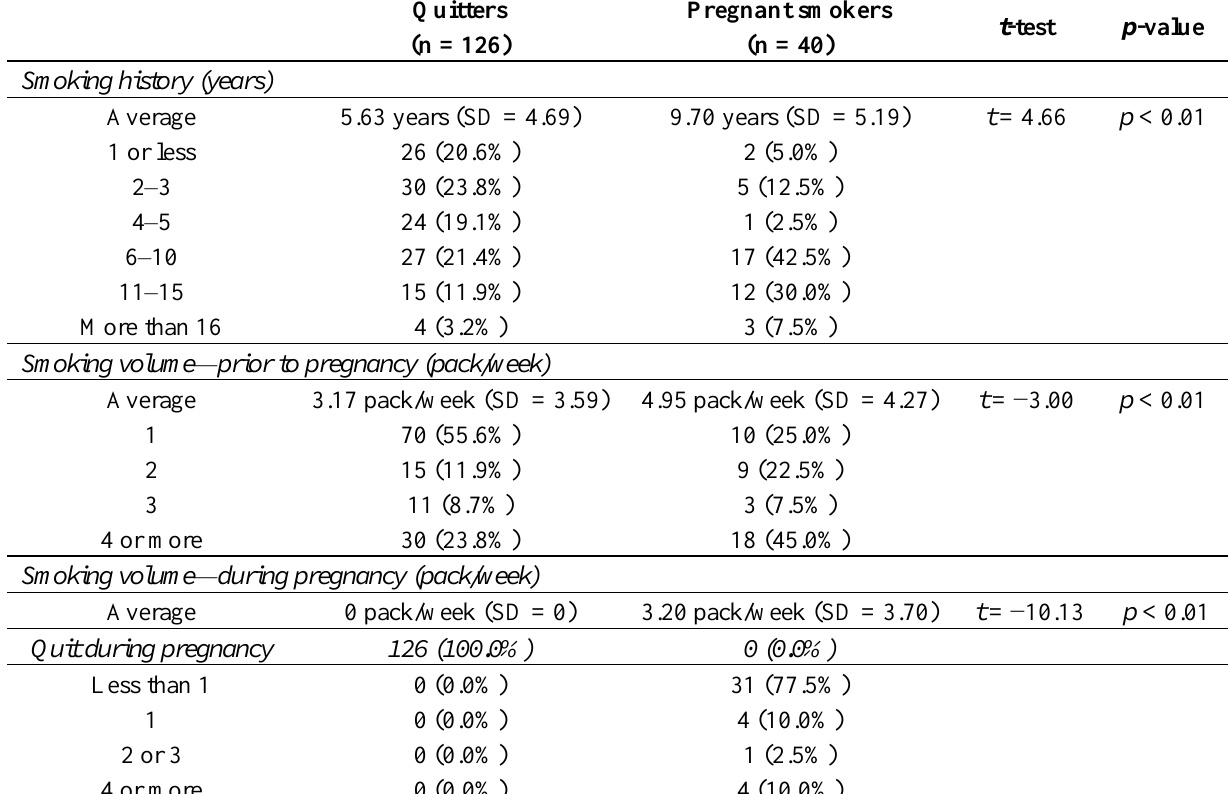
Table 2. Comparison between the groups of participants who were quitter and pregnant smoker in terms of smoking history and volume (n =